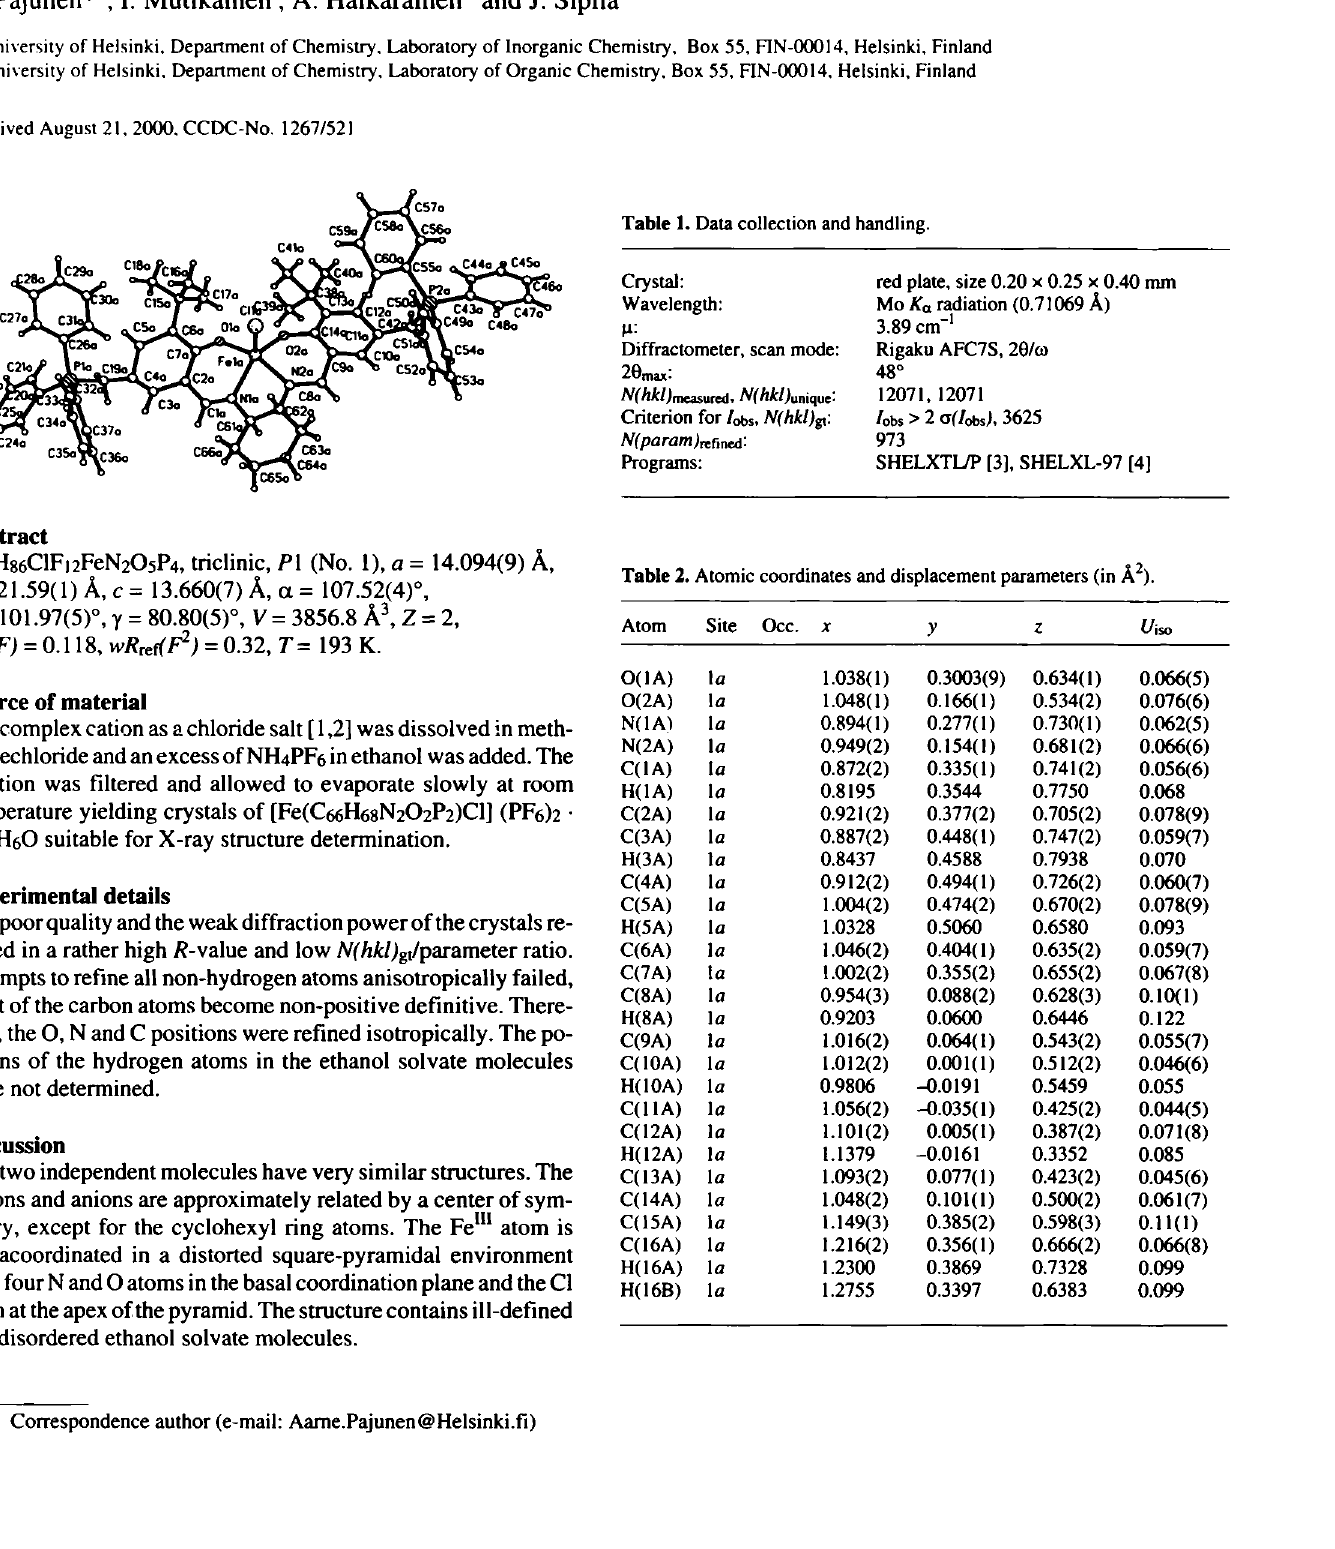
Table 2. Atomic coordinates and displacement parameters (in A 2